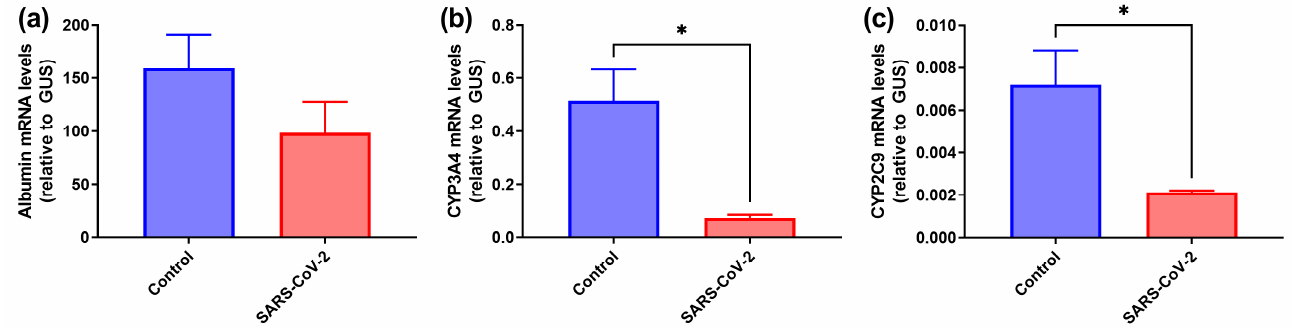
Figure 3. SARS-CoV-2 induces a decrease in the expression of hepatocyte-specific genes. HepaRGdiff cells were infected and incubated in the presence of SARS-CoV-2 for 2 h and expression of albumin ( a ), cytochromes (CYP) 3A4 ( b ) and 2C9 ( c ) was quantified by RT-qPCR 4 d.p.i. The levels were normalized to the levels of GUS mRNA. The values represent the means ± standard deviation (S.D.). * p < 0.05.